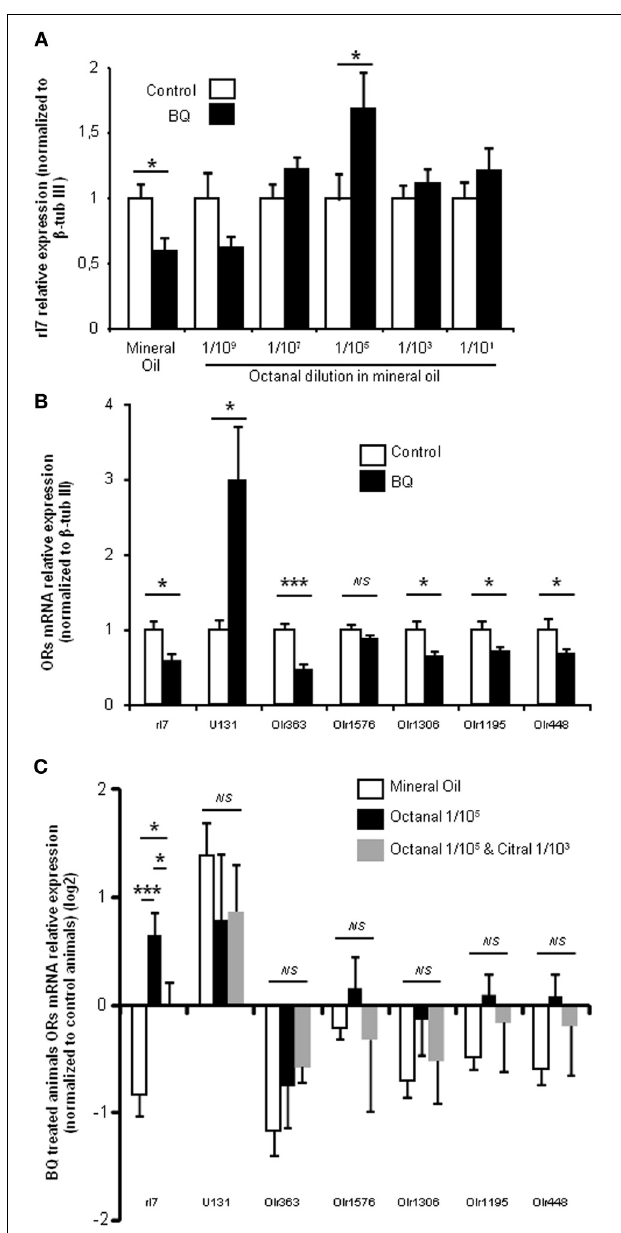
FIGURE 4 | BQ treatment globally decreases OR transcripts in the OE, and rI7 activation specifically enhances its expression. (A) qPCR analysis of rI7 expression in the olfactory mucosa of rats treated with BQ or vehicle while odorized with a range of octanal dilutions. (B) OR expression analysis for animals treated with BQ and control littermates in presence of mineral oil. (C) Effect on OR expression of different odorization during BQ treatment. Values are normalized to control animals and expressed on log 2 scale. ( n = 6; ∗ P < 0 . 05; ∗∗∗ P < 0 .